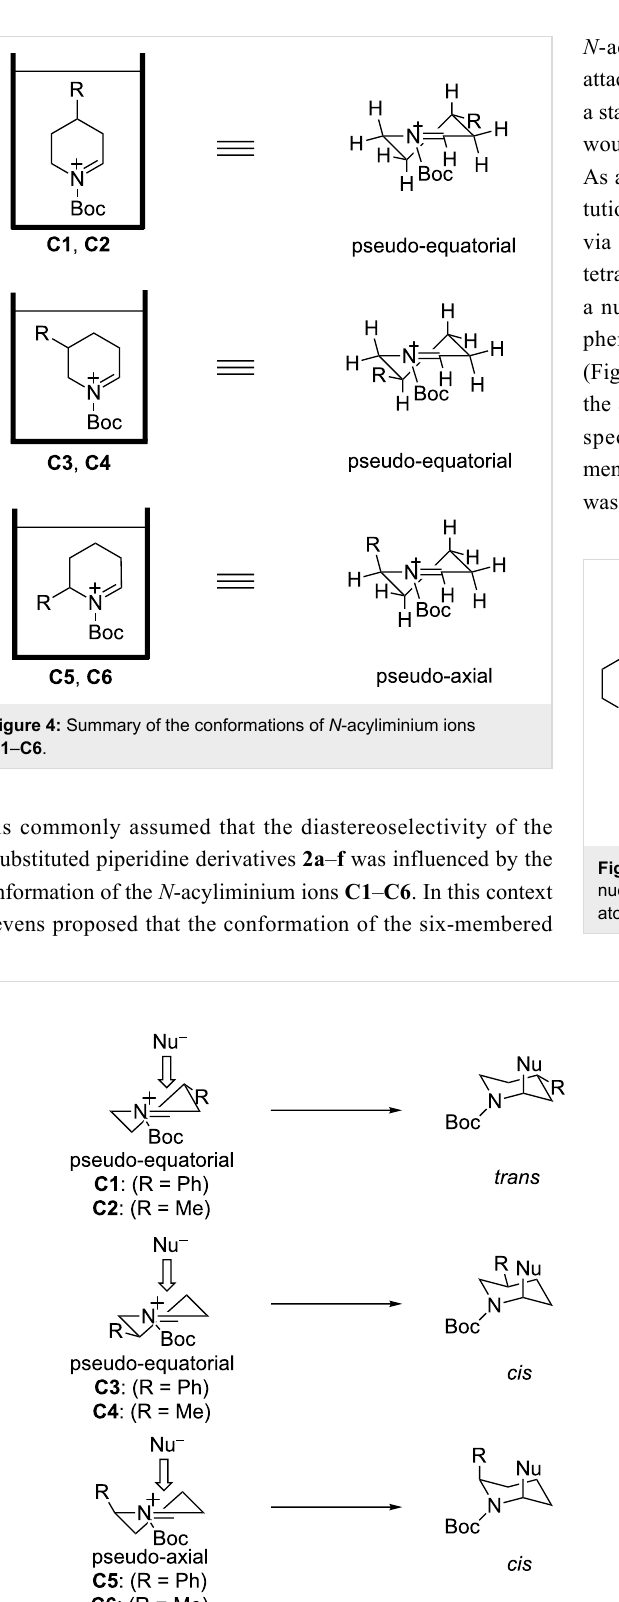
Figure 6: A plausible mechanism of the observed diastereoselective reaction of the N -acyliminium ions.